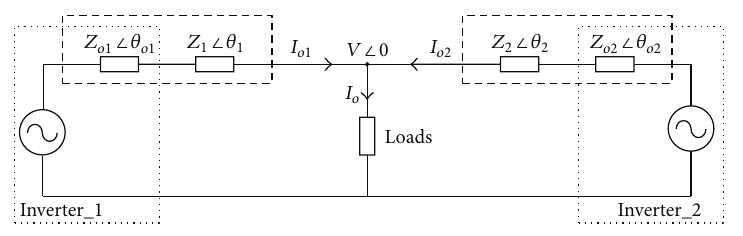
Figure 2: Simplified diagram of inverter-based microgrid.